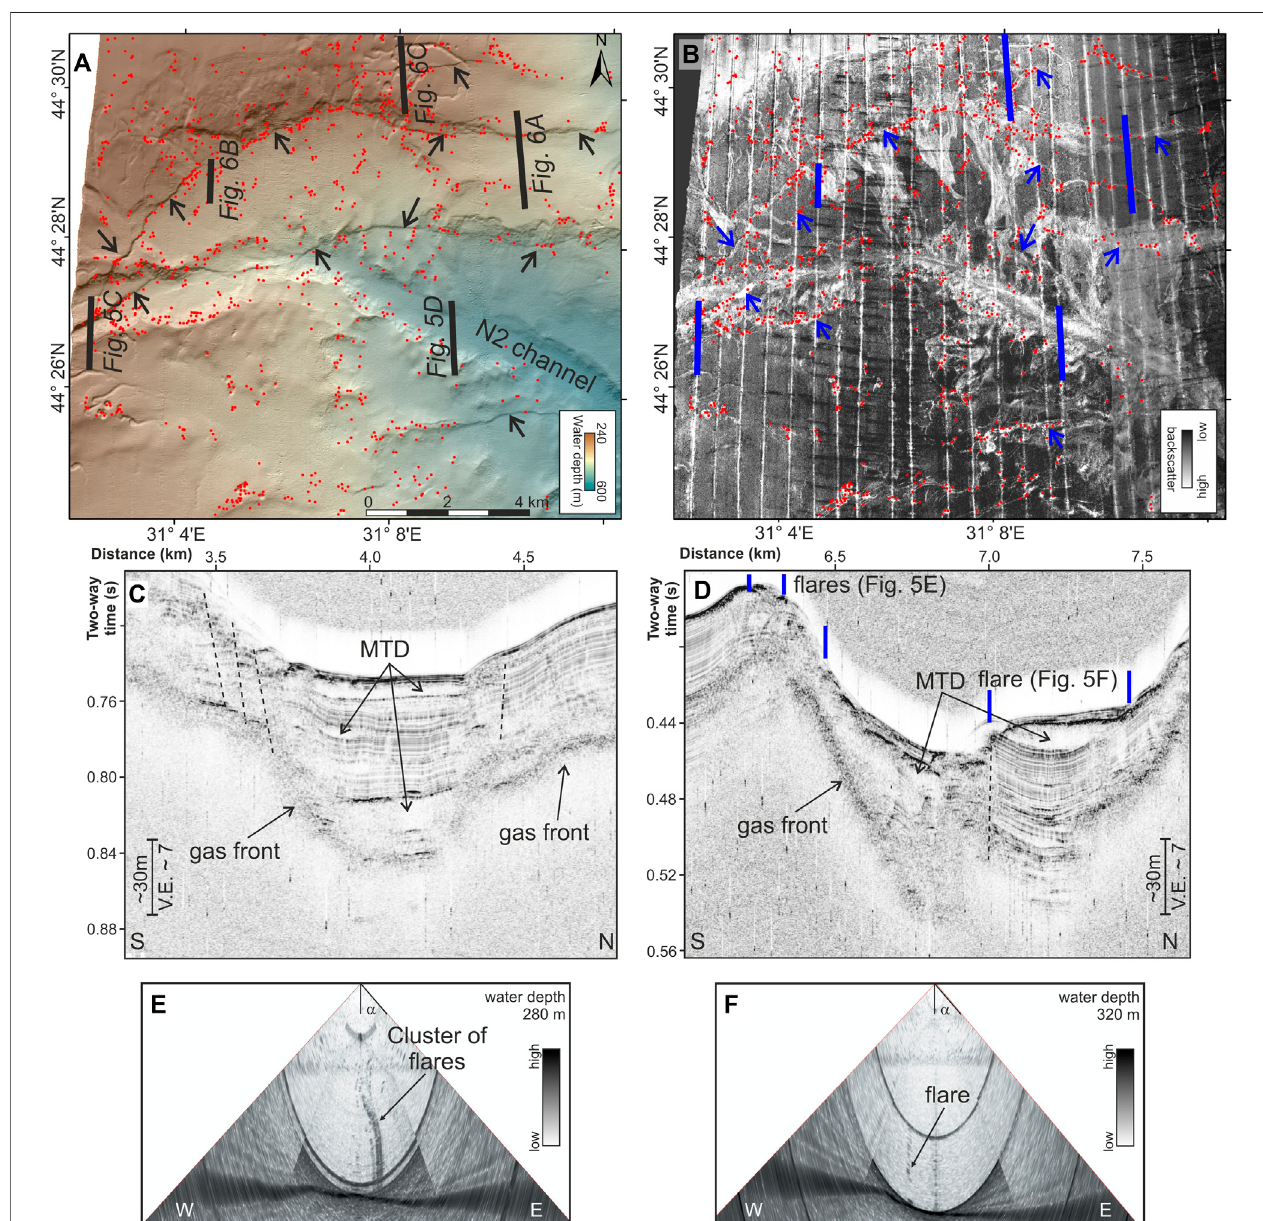
FIGURE 5 | Examples from the N2 channel systems: (A) multibeam bathymetry and (B) sea fl oor backscatter. Location of gas seeps are shown as red dots. Dominant E-W trending normal faults are indicated by arrows. Buried, small-scale mass-transport deposits show high sea fl oor backscatter. Sub-bottom pro fi ler data (black/bluethicklines in (A,B) )acrossthe talwegofthe EW-canyon system showing (C) 3 – 5 mthick drape on topofthe youngest mass-transport deposit from thetime when the canyon was last active, (D) fault cutting the talweg. Faults are indicated by dashed black lines. (E,F) are examples of gas fl ares from the EM710 water column data along section shown in (D) . Beam-opening angle α is 60 °